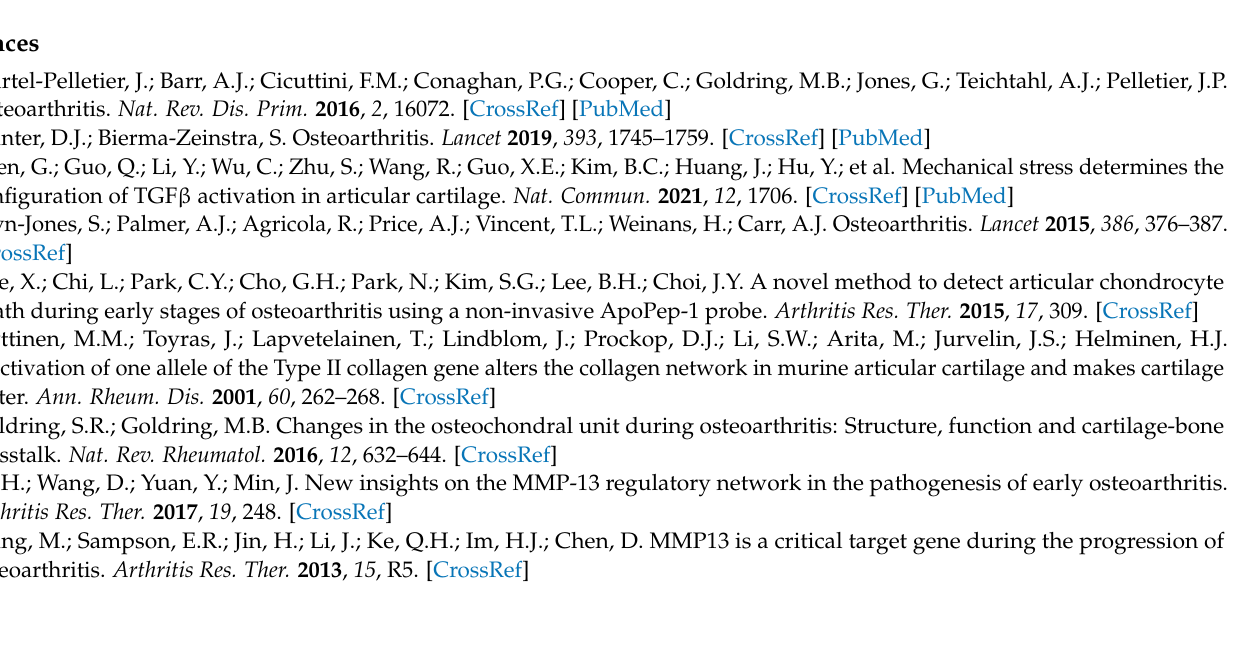
expression. Figure S2: The Gdf5-Cre transgene is active in articular